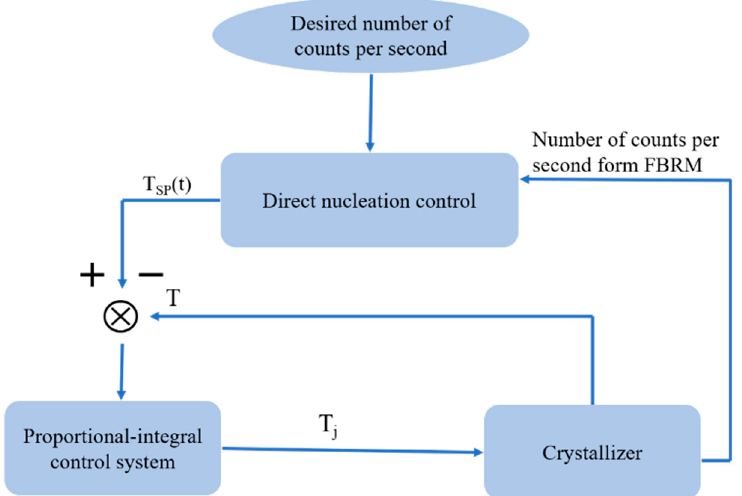
Figure 4. Control loop of the direct nucleation control strategy.